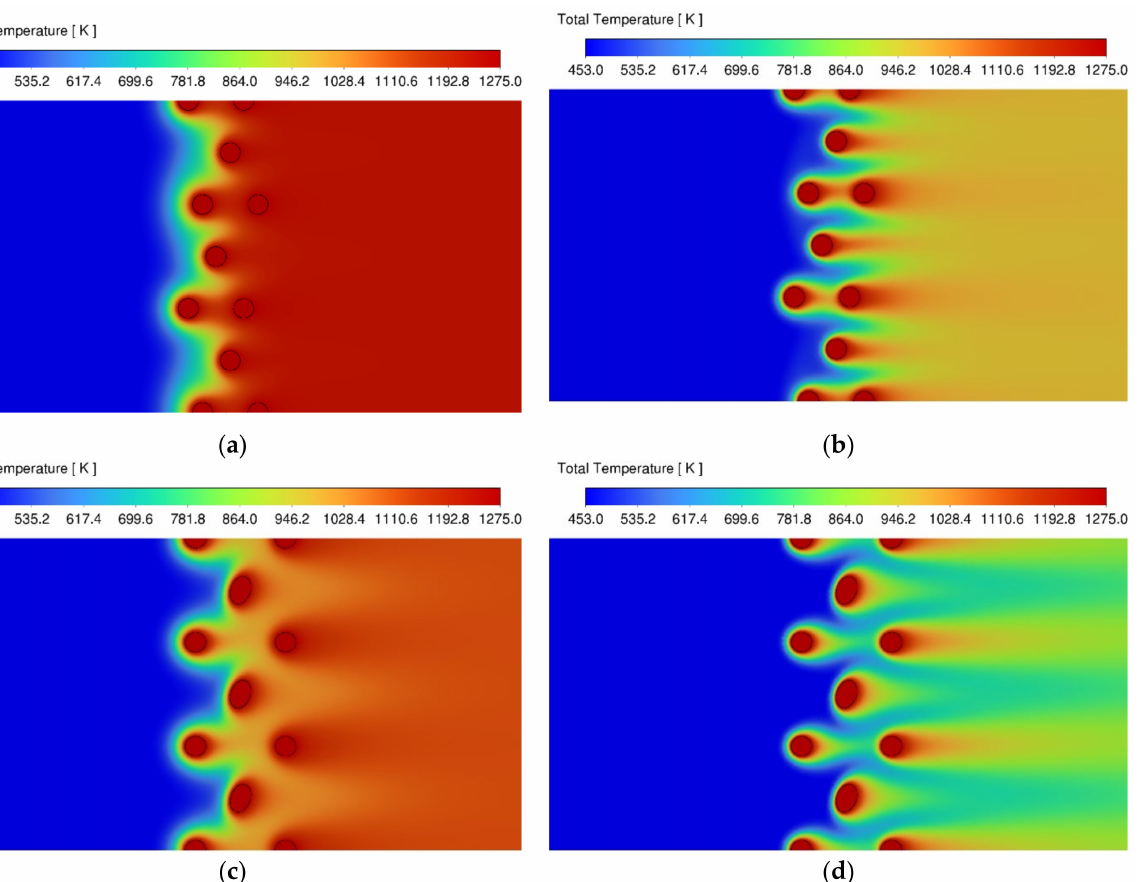
Figure 5. Temperature contours for: ( a ) Geometry A, contact time of 0.001 s; ( b ) Geometry A, contact time of 0.00025 s; ( c ) Geometry B, contact time of 0.001 s; ( d ) Geometry B, contact time of 0.00025